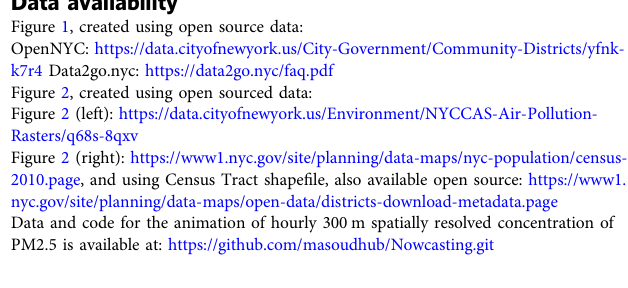
Figure 1, created using open source data: OpenNYC: https://data.cityofnewyork.us/City-Government/Community-Districts/yfnk- k7r4 Data2go.nyc: https://data2go.nyc/faq.pdf Figure 2, created using open sourced data: Figure 2 (left): https://data.cityofnewyork.us/Environment/NYCCAS-Air-Pollution- Rasters/q68s-8qxv Figure 2 (right): https://www1.nyc.gov/site/planning/data-maps/nyc-population/census- 2010.page, and using Census Tract shape fi le, also available open source: